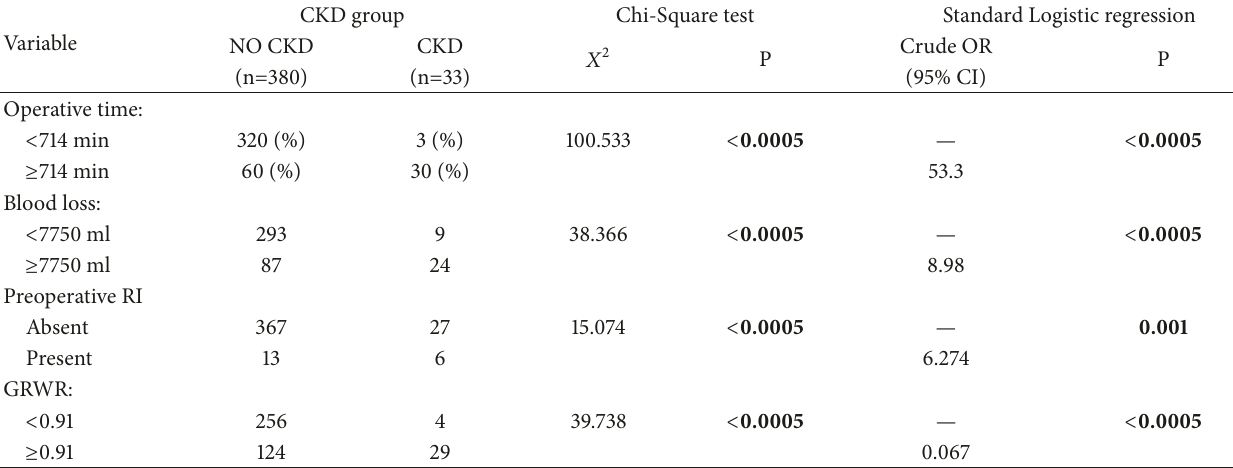
Table 4: Univariate regression analysis for predicting the likelihood of chronic kidney disease at one year.